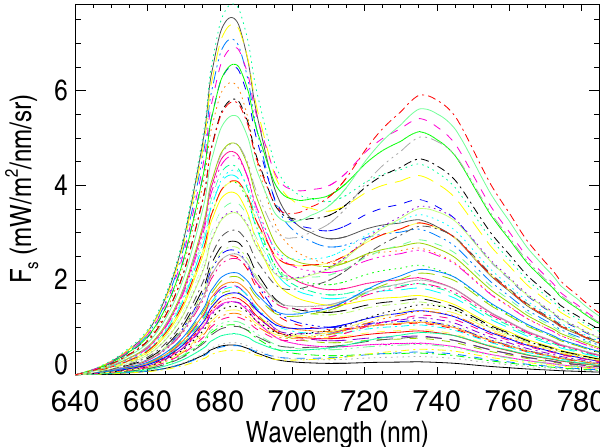
Fig. 2. Simulated solar spectra based on Chance and Kurucz (2010) for different instrumentation showing Fraunhofer line structure (FWHM = 0.5nm is for a GOME-2-like instrument). Fig. 3. Canopy-level spectral fluorescence as specified for the range of conditions in the simulated data set.